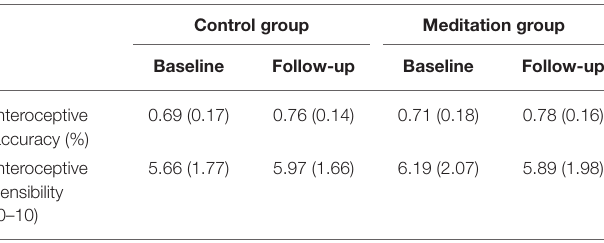
TABLE 4 | Interoceptive accuracy and sensibility means and standard deviations at baseline and follow-up.